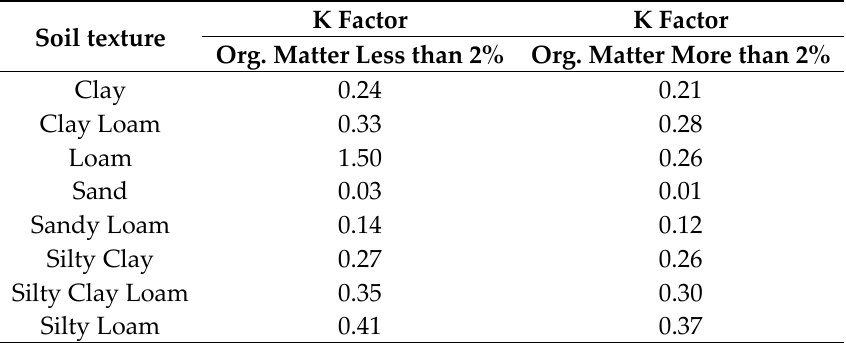
Table 1. K values as they were assigned according to soil texture